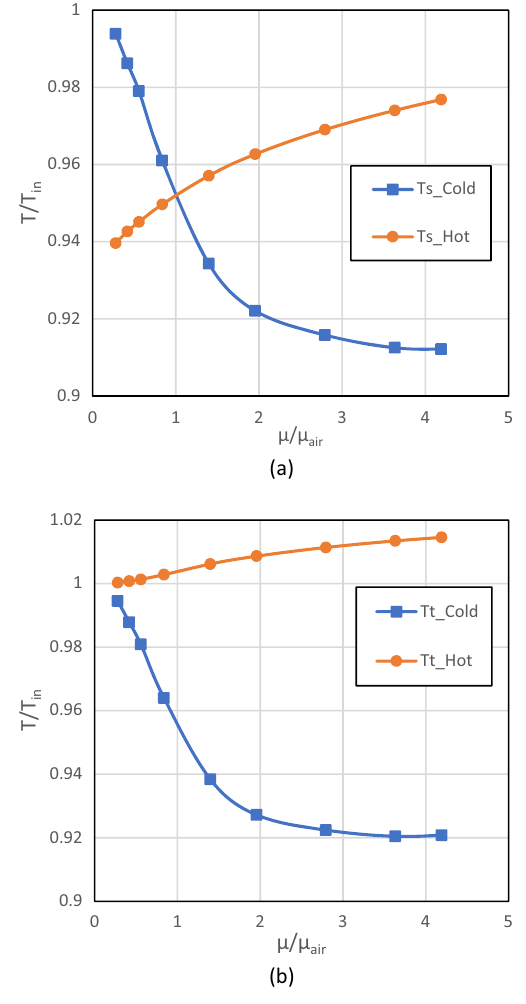
Fig. 17 Effect of dynamic viscosity ratios on dimensionless a Static and b total outlet temperatures with 400 kPa at the inlet, 0 kPa at the cold outlet and 30 kPa at the hot outlet